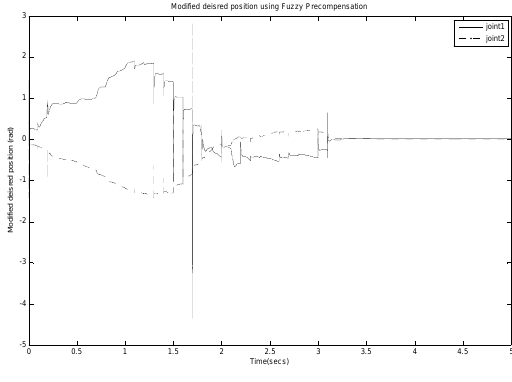
Fig.8. Modified desired position using fuzzy precompensation.